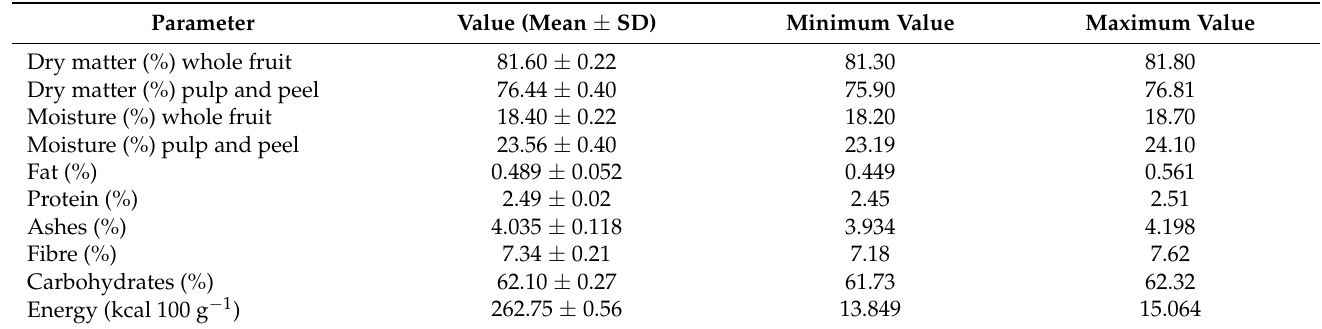
Table 8. Proximal parameters for fresh weight of hackberry fruits (mean ± SD, minimum and maximum value, n = 3).